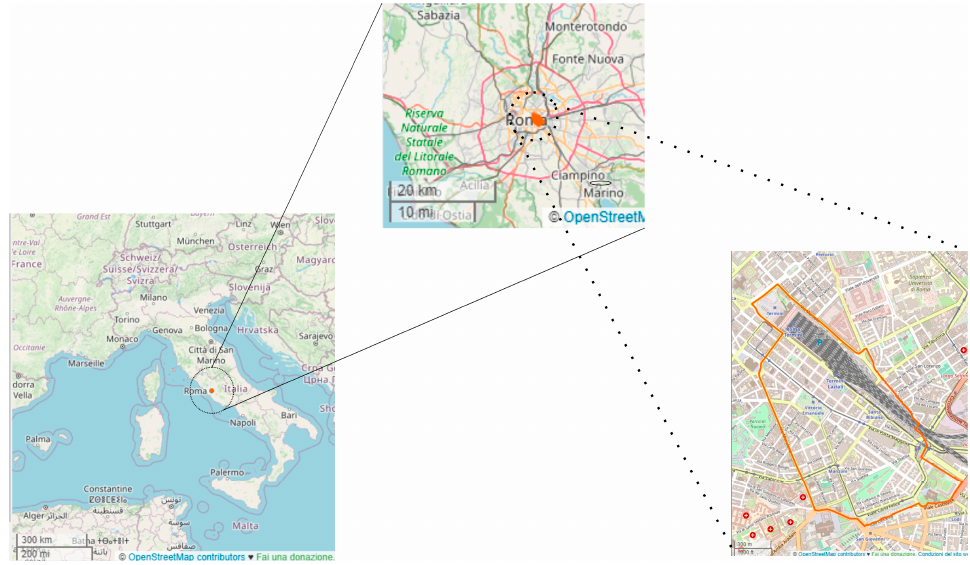
Figure 1. Location and Boundaries of Esquilino. Source: OpenStreetMap.